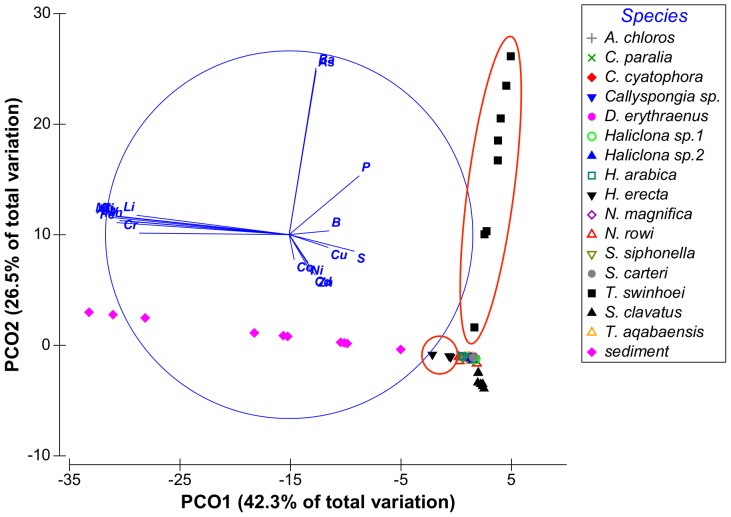
Distribution of sponge and sediment samples along PCOII vectors 1 and 2, explaining 68% of all variation between samples.Samples of interest are circled in red.